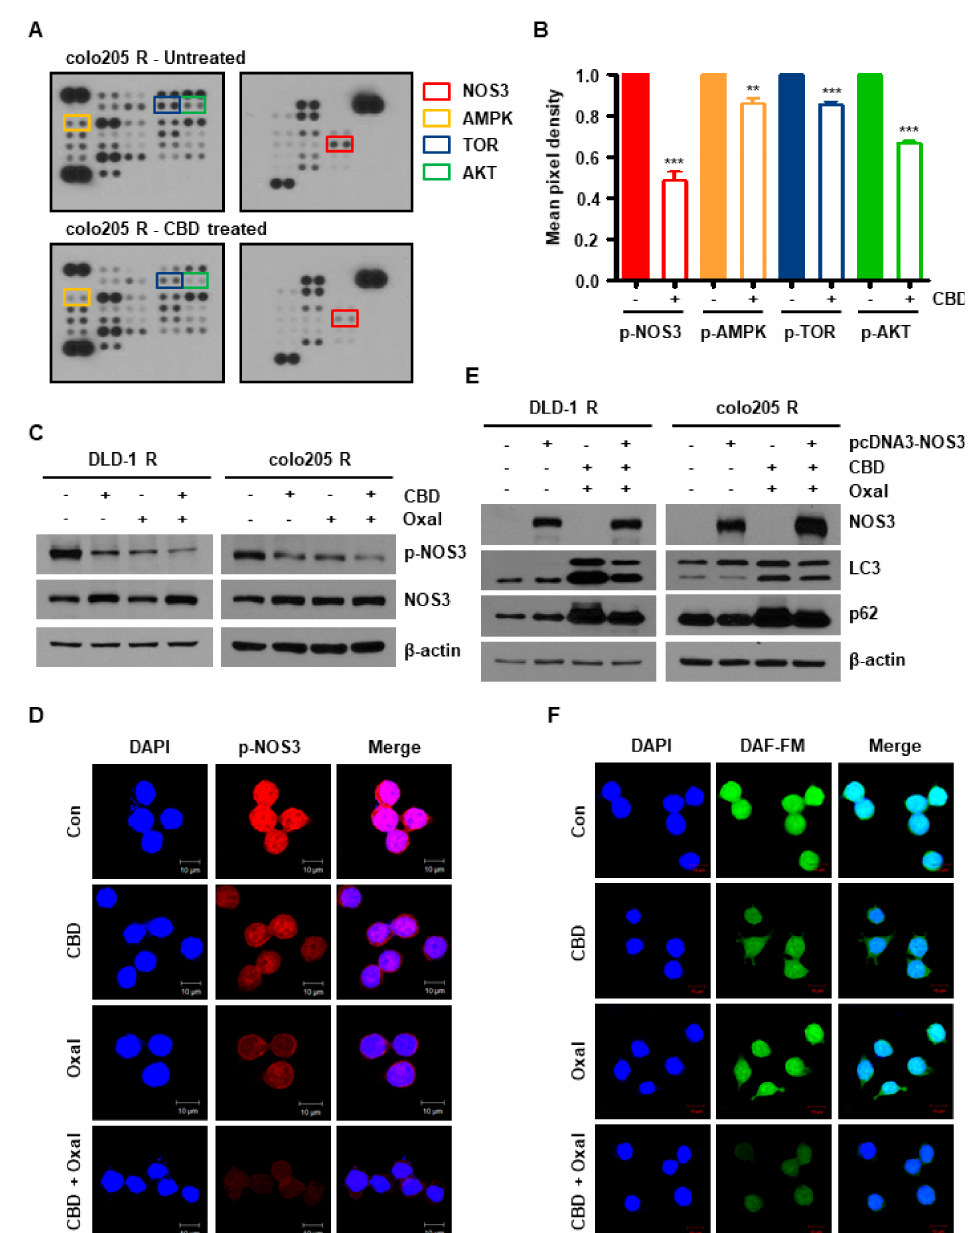
Figure 2. Downregulation of phospho-nitric oxide synthase 3 (NOS3) induces autophagic cell death. ( A , B ) colo205 R cells were treated with 4 µ M CBD for 8 h. ( A ) Cell lysates were then hybridized to the Phospho-Kinase Array kit. ( B ) The graph represents the quantification of mean pixel density using the Image J program. ** p < 0.01 and *** p < 0.001. ( C ) Protein levels of NOS3 and phospho-NOS3 were determined by western blotting in oxaliplatin-resistant cells treated with oxaliplatin and CBD for 24 h. ( D ) colo205 R cells were immunostained with phopho-NOS3 following treatment with oxaliplatin and CBD. Images were captured using a confocal microscope (scale bar, 10 µ m). ( E ) pcDNA3-NOS3-GFP-transfected cells were treated with oxaliplatin and CBD for 24 h. Protein levels of NOS3, phospho-NOS3, LC3, and p62 were determined by immunoblotting. ( F ) Colo205 R cells were treated with oxaliplatin and CBD. Cells were then stained with 10 µ M 4-amino-5-methylamino-2’,7’-difluorescein (DAF-FM) dye for 40 min at 37 ◦ C. Images were captured using a confocal microscope (scale bar, 10 µ